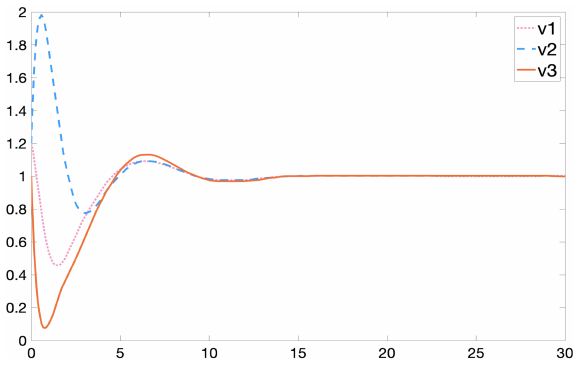
Figure 6. The Speed of Three Followers Hanging Points.